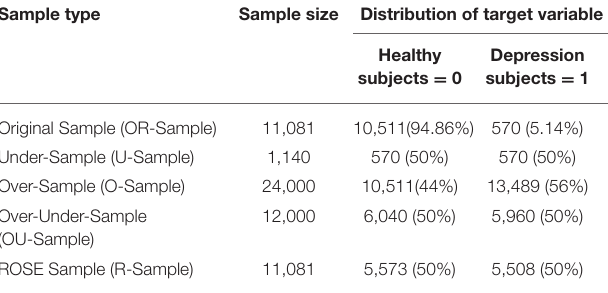
TABLE 2 | Distribution of target